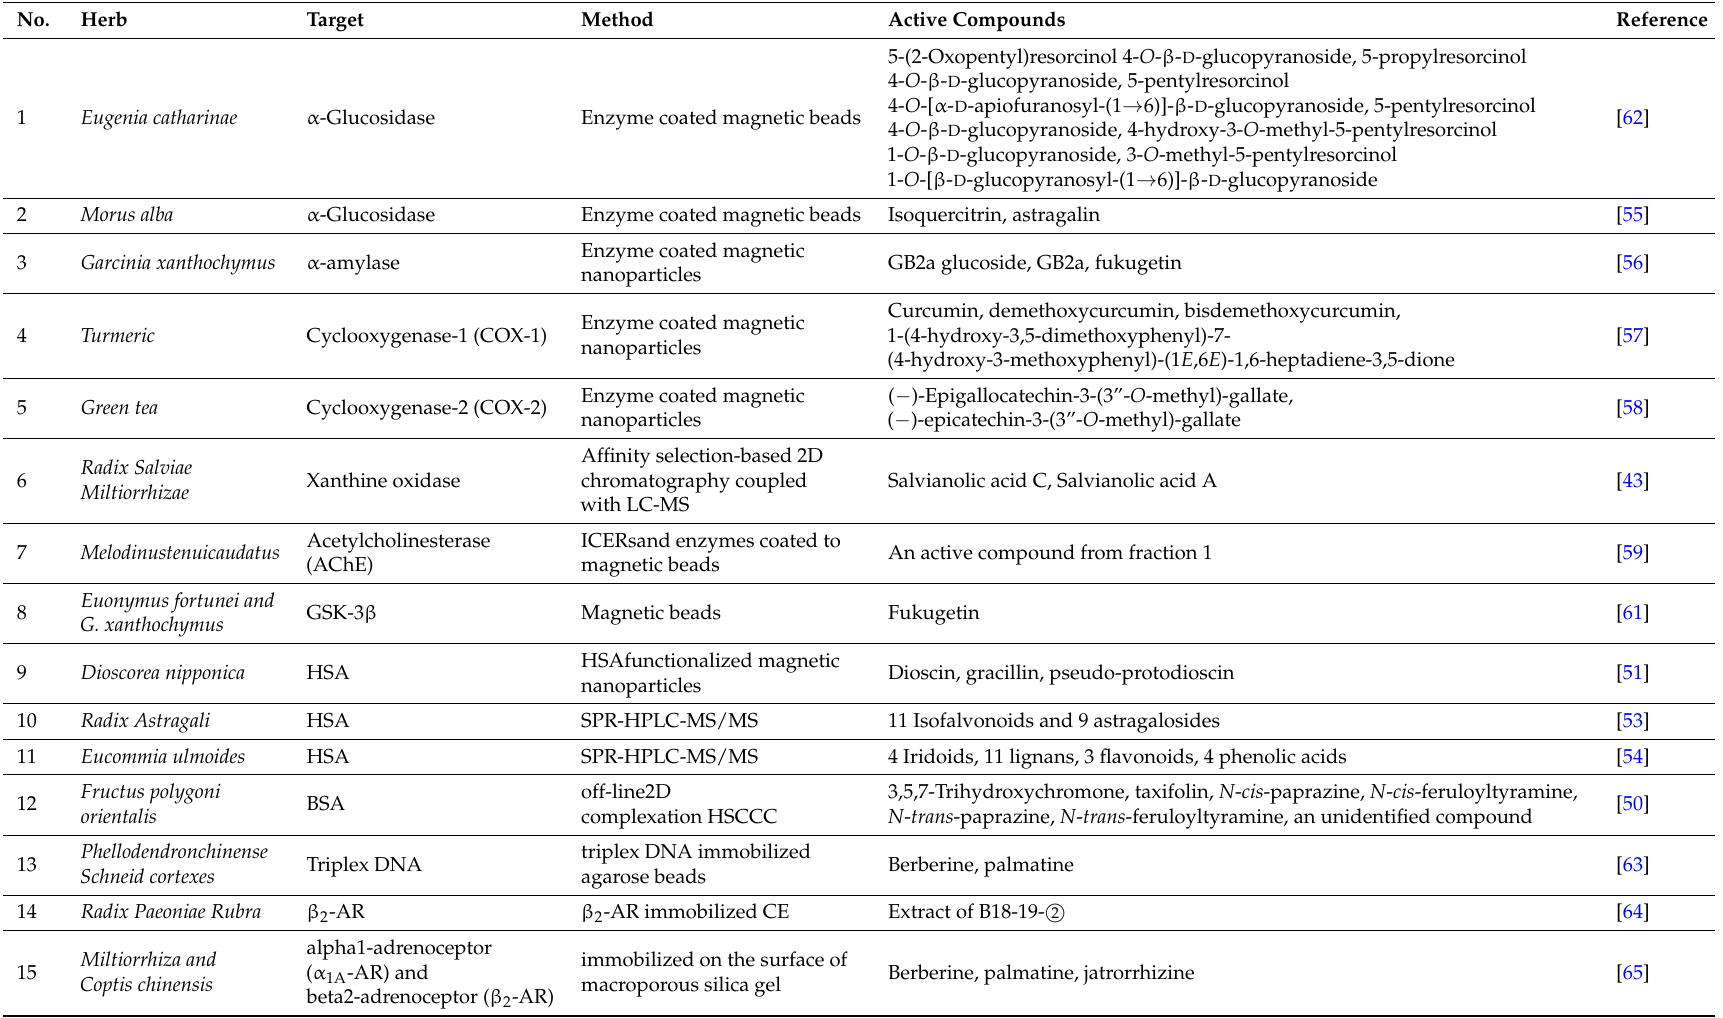
Table 1. Applications on TCM by various ligand fishing